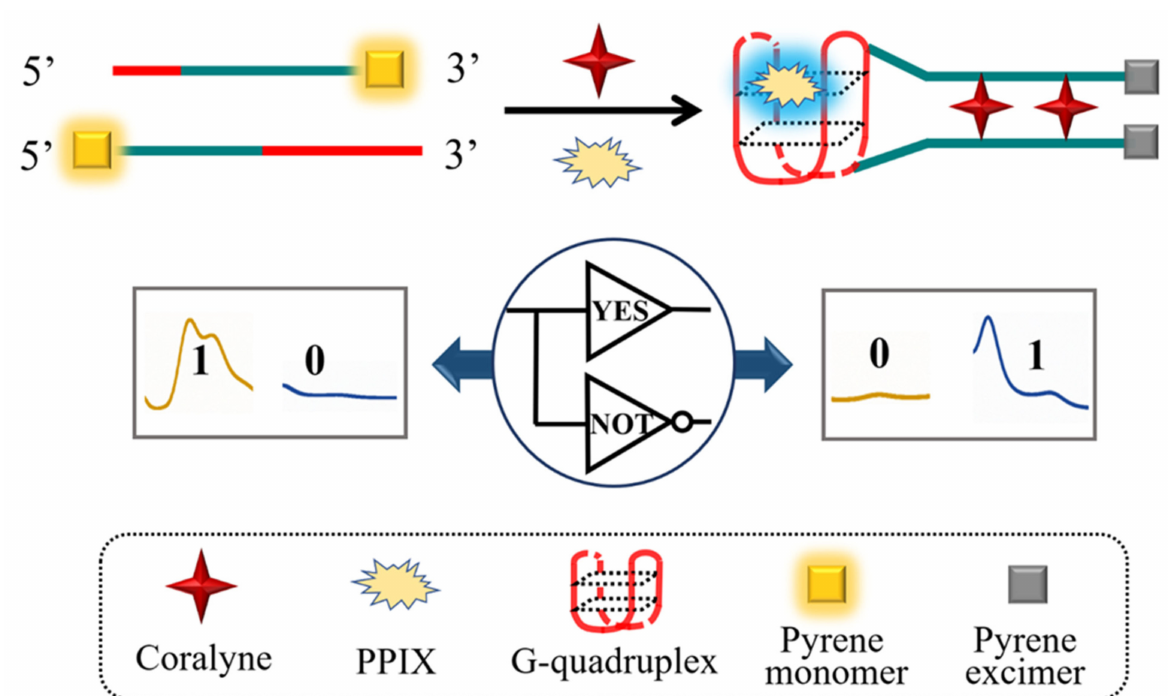
Scheme 1. Mechanism of the ratiometric fluorescent platform that programmed by contrary logic pair for highly sensitive and selective detection of